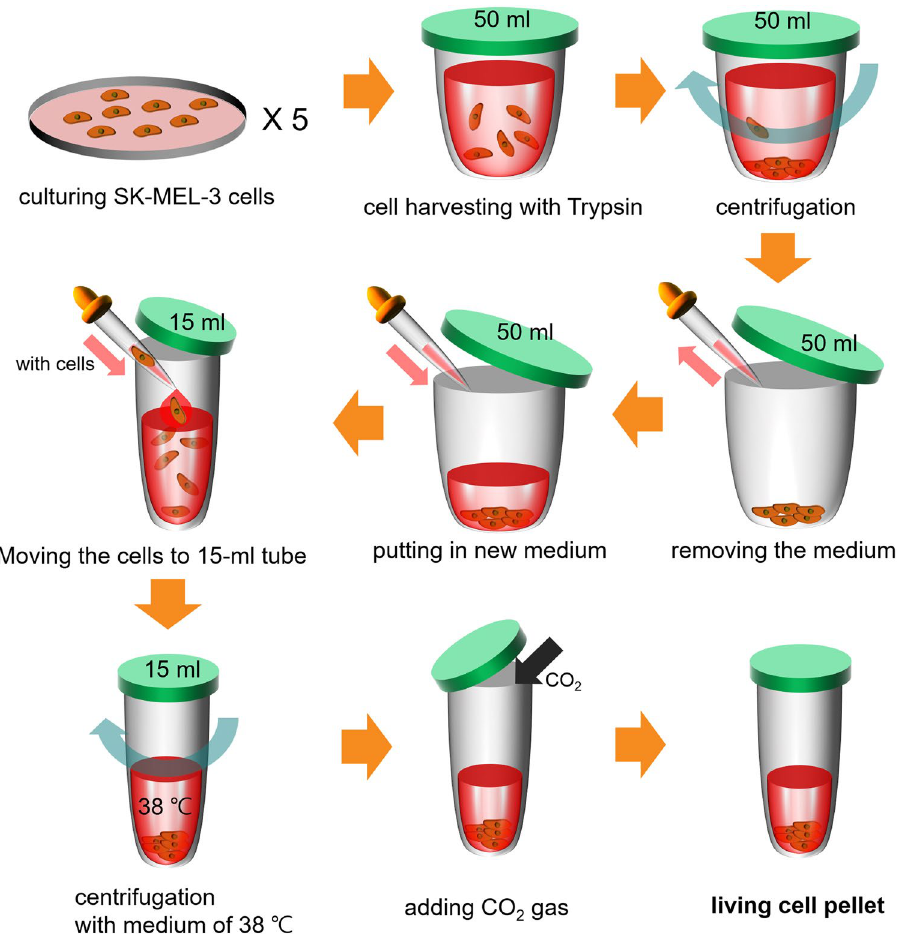
Figure 8. The production process of SK-MEL-3 melanoma living cell pellets. The cell pellets are primarily located at the bottom of tubes to ensure effective irradiation with THz radiation because of the absorption of THz radiation by water